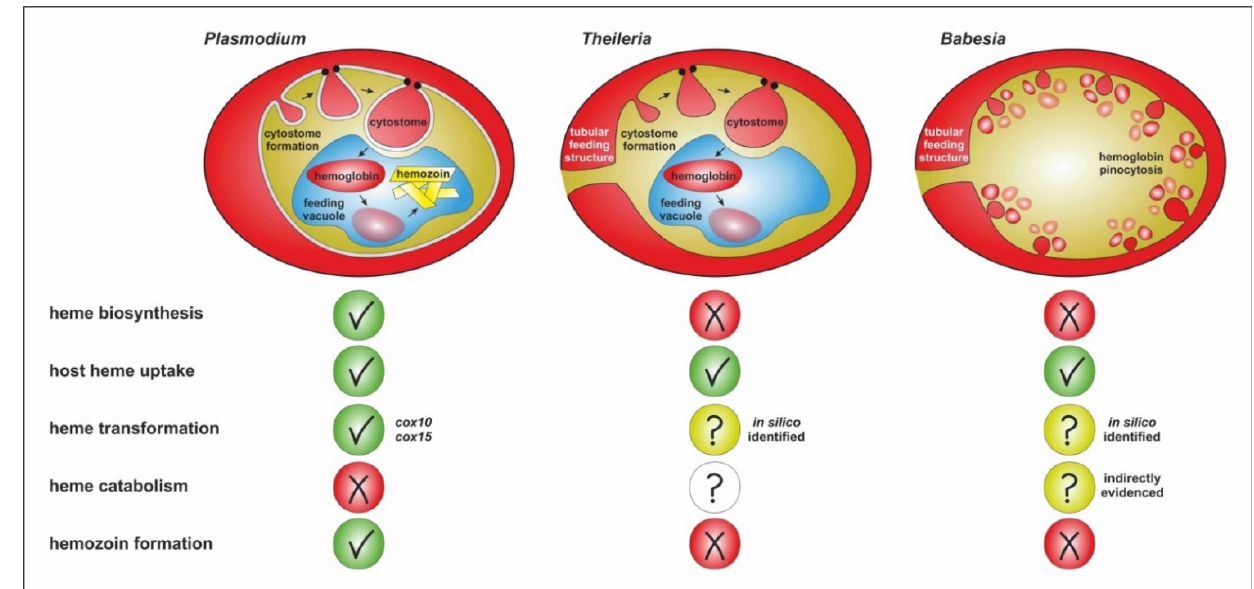
Figure 1. Schematic depiction of the major cellular differences of Plasmodium , Theileria and Babesia trophozoites uptaking and processing host RBC cytosol proteins, including the utilization and detoxification of resulting heme molecules. The heme transformation pathway has been functionally proven only in Plasmodium , but the direct homologues cox 10 and cox 15 genes ( cox = cytochrome c oxidase) that encode the key enzymes of this pathway have been determined from the Babesia/Theileria genomes. Heme catabolism pathway is to date only indirectly evidenced in Babesia by the presence of a gene encoding a heme oxygenase-like homologue in the genome and the identification of higher carboxyhemoglobin fractions in dogs suffering from severe babesiosis